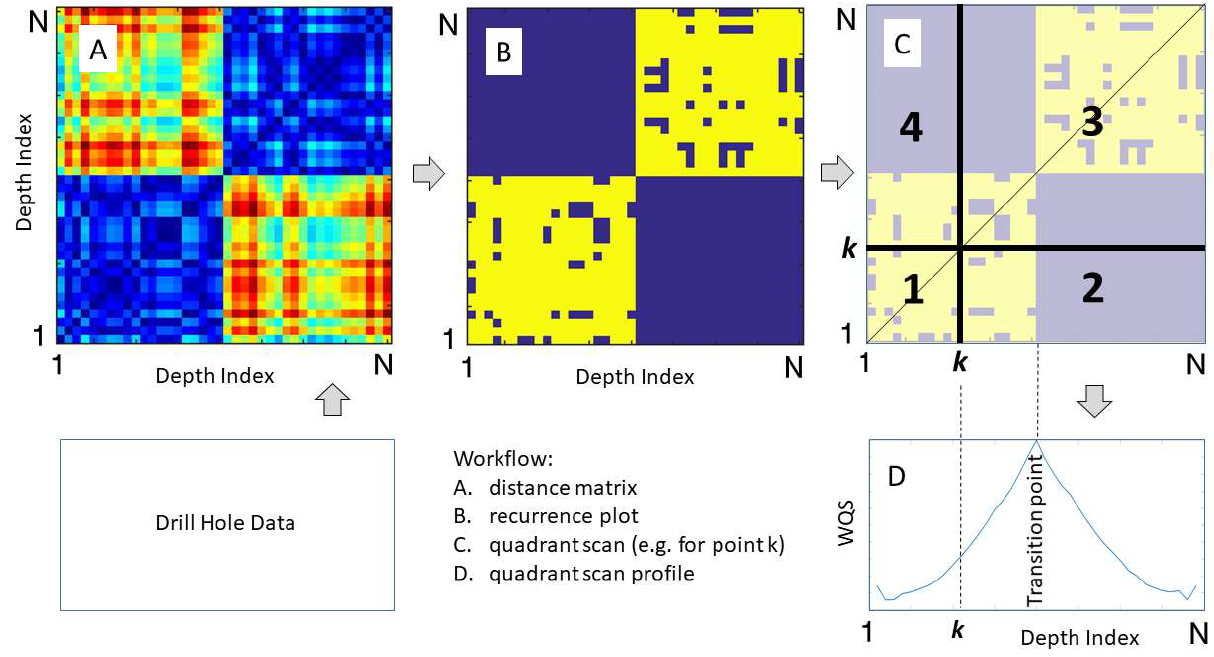
Figure 4. A flowchart demonstrating the steps of the proposed mathematical method. In subplot ( A ), the colours represent the difference between each sample and all other samples in the drill hole using the multivariate data. For the binary recurrence matrix, in subplot ( B ), blue represents 0 (above the threshold) and yellow represents 1 (below the threshold). At each depth index, the recurrence matrix is divided into four quadrants, shown in subplot ( C ), the black vertical and horizontal lines demonstrate the division for depth index k. The ratio of quadrant values transforms the 2D plot into a simple function, subplot ( D ), where maxima indicate transition points in the input data.